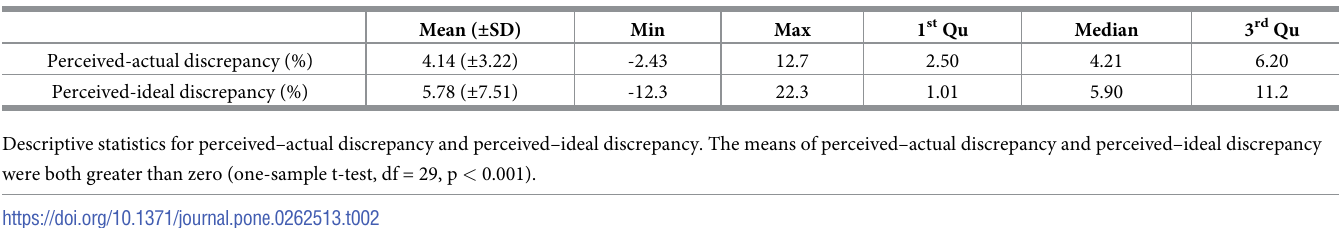
Table 2. Descriptive statistics for body-image